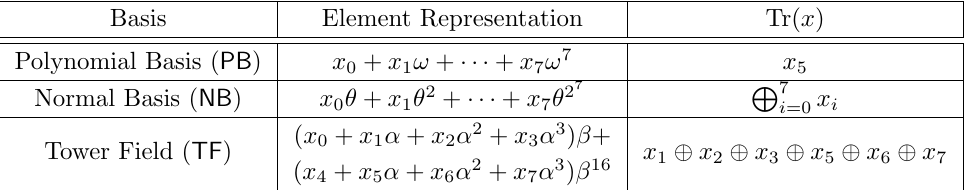
F Using Different 2 8 ∈